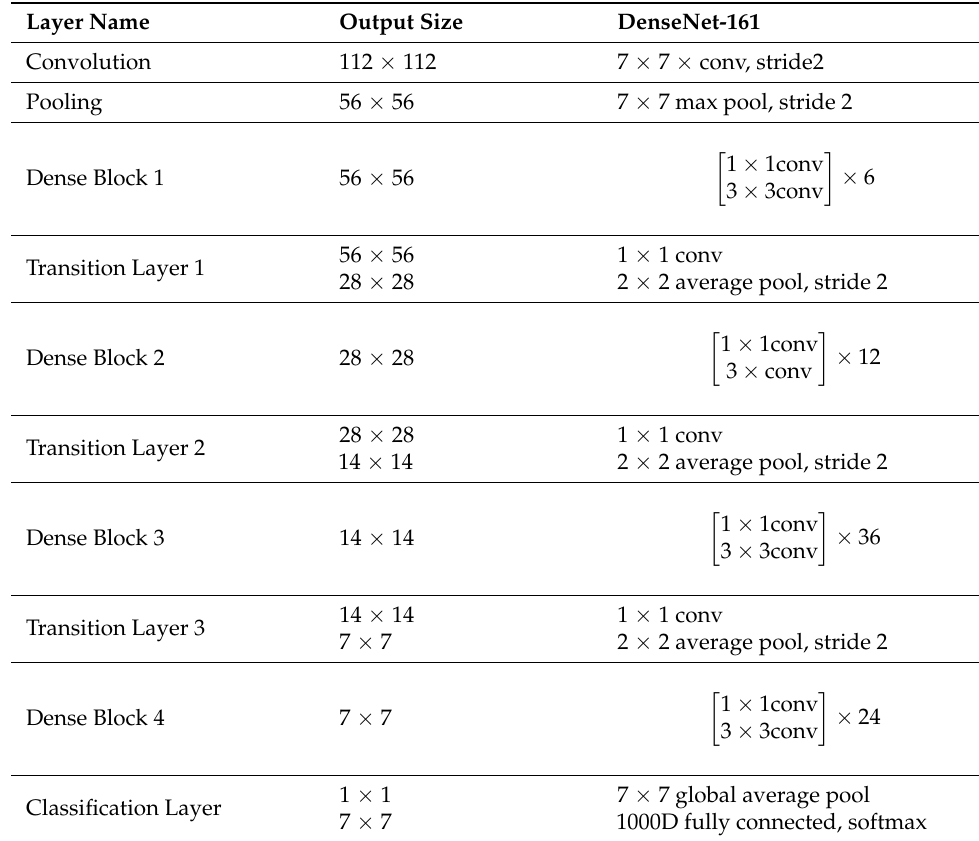
Table 5. DenseNet-161 architecture